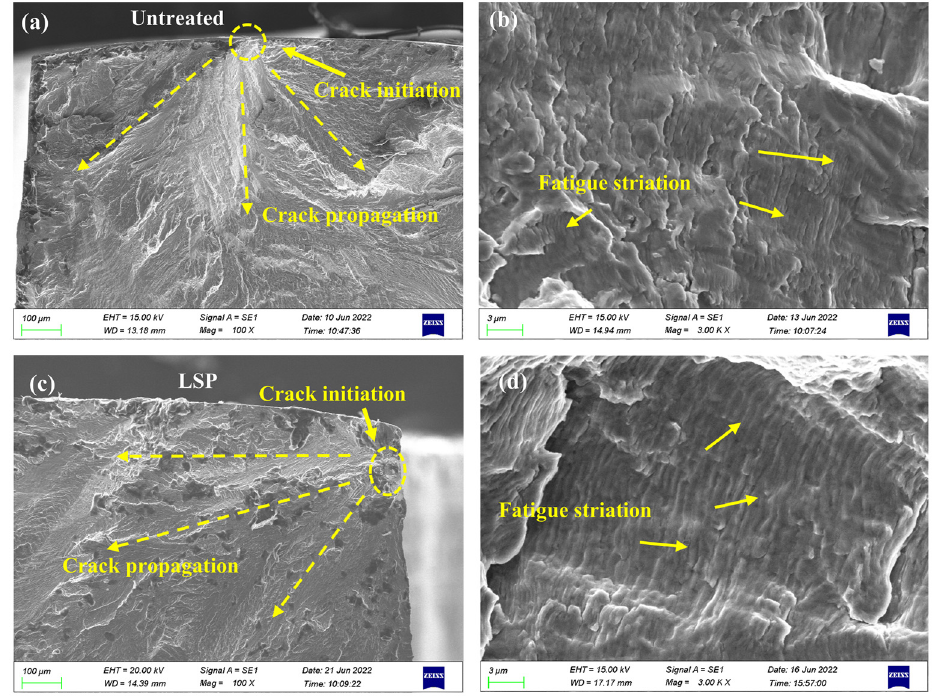
Figure 12. Fracture morphologies of specimens with and without LSP treatment: ( a ) crack initia- tion region of untreated specimens, ( b ) crack propagation region of untreated specimens, ( c ) crack initiation region of LSPed specimens, and ( d ) crack propagation region of LSPed specimens.